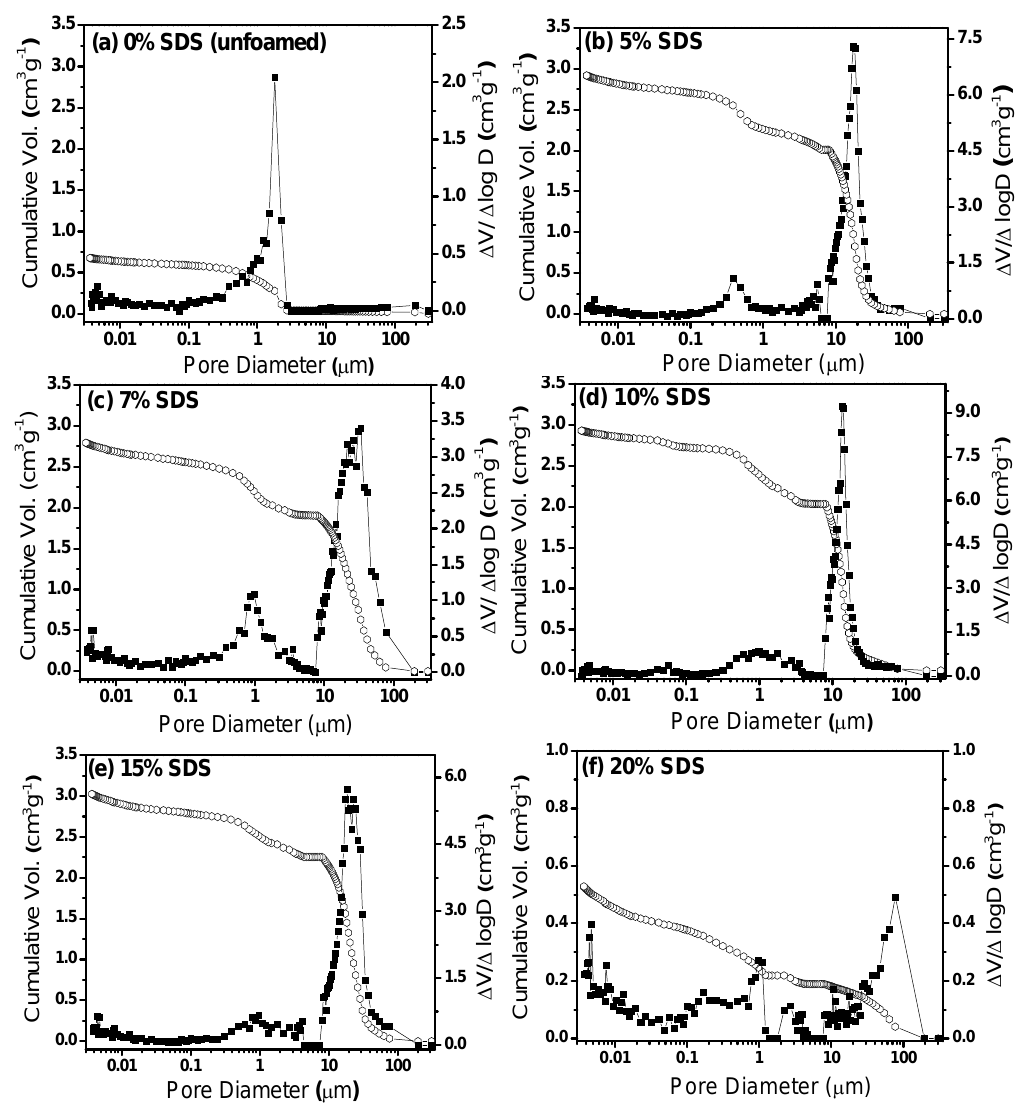
Figure 2. Cumulative and differential pore size distributions of ceramic foams prepared from liquid foams containing different amounts of SDS: ( a ) 0%; ( b ) 5%; ( c ) 7%; ( d ) 10%; ( e ) 15%; and ( f )